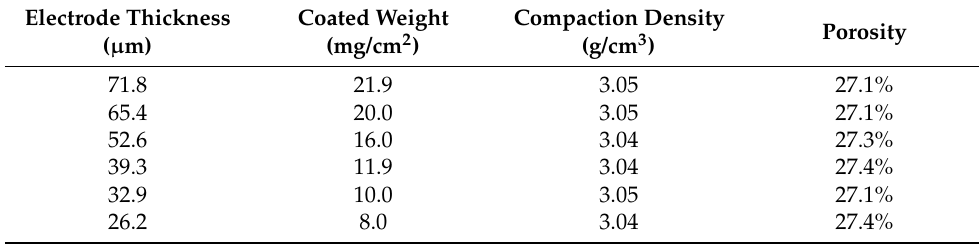
Table 2. Physical parameters of the positive